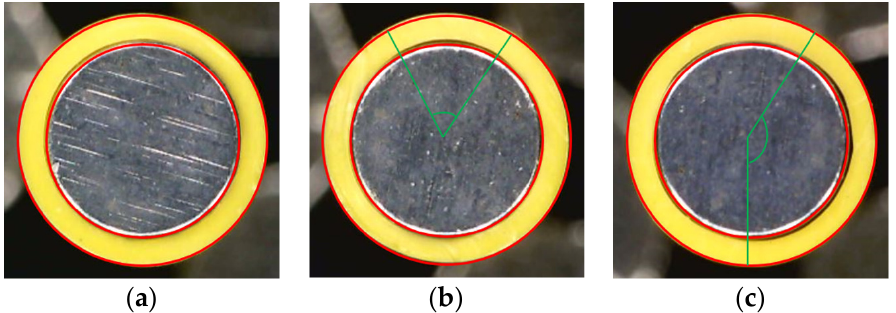
Figure 9. Quality of catheters according to the level of screw wear: ( a ) wear level 1; ( b ) wear level 2; ( c ) wear level 3. Table 1. Results of the flow rate measurement test according to screw wear level.